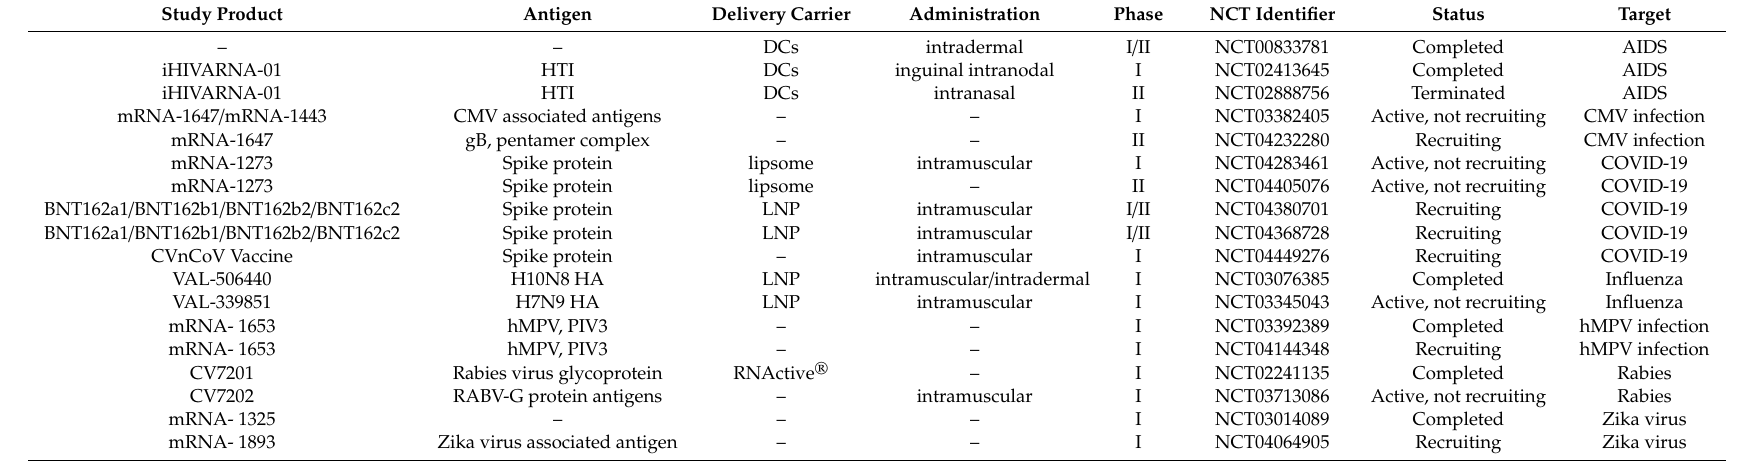
Table 2. Examples of mRNA vaccine clinical trials for infectious